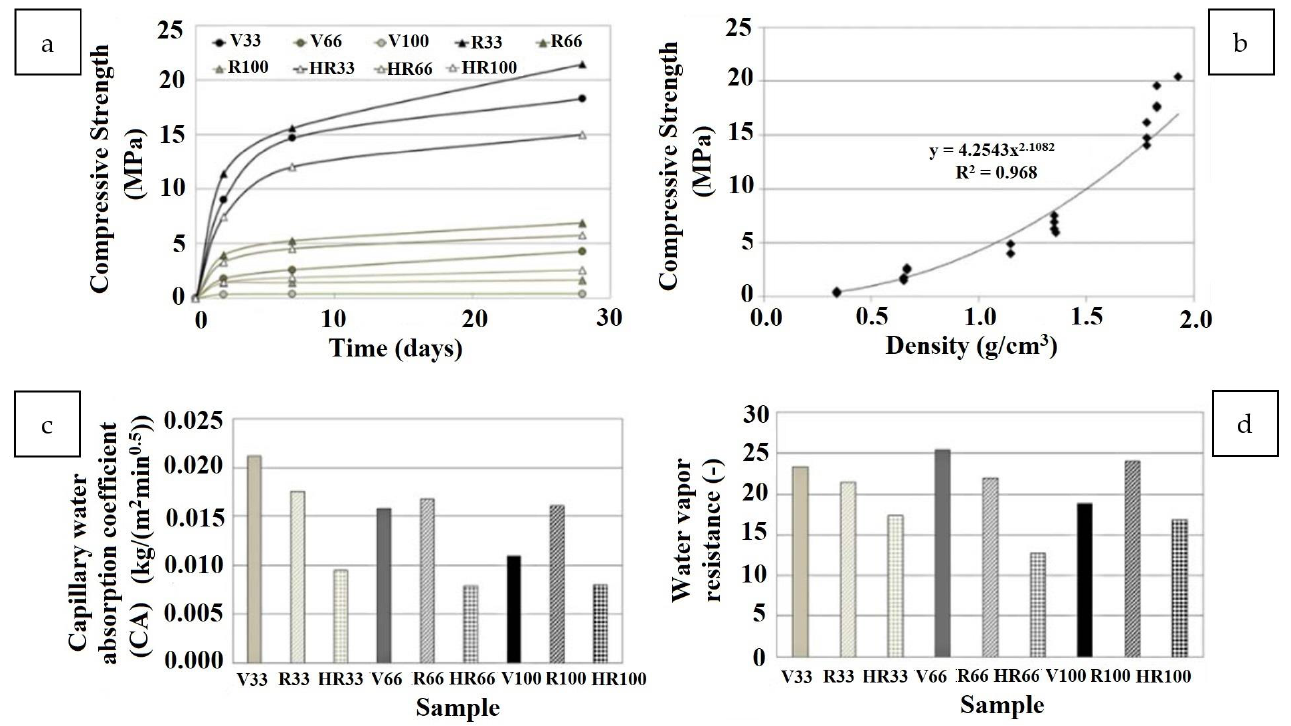
Figure 20. Compressive strength development with ( a ) time and ( b ) mortar density of EPS-based mortars, ( c ) Capillary water absorption coefficient (CA), and ( d ) water vapor resistance ( µ ) of lightweight EPS-based mortars. Samples V implies that virgin EPS replaces the sand volume, R implies that recycled EPS replaces the sand volume, and HR implies that recycled EPS with 0.5% silane agent replaces the sand volume, while the numbers indicate the extent of volume replacement. Reprinted with permission from ref.